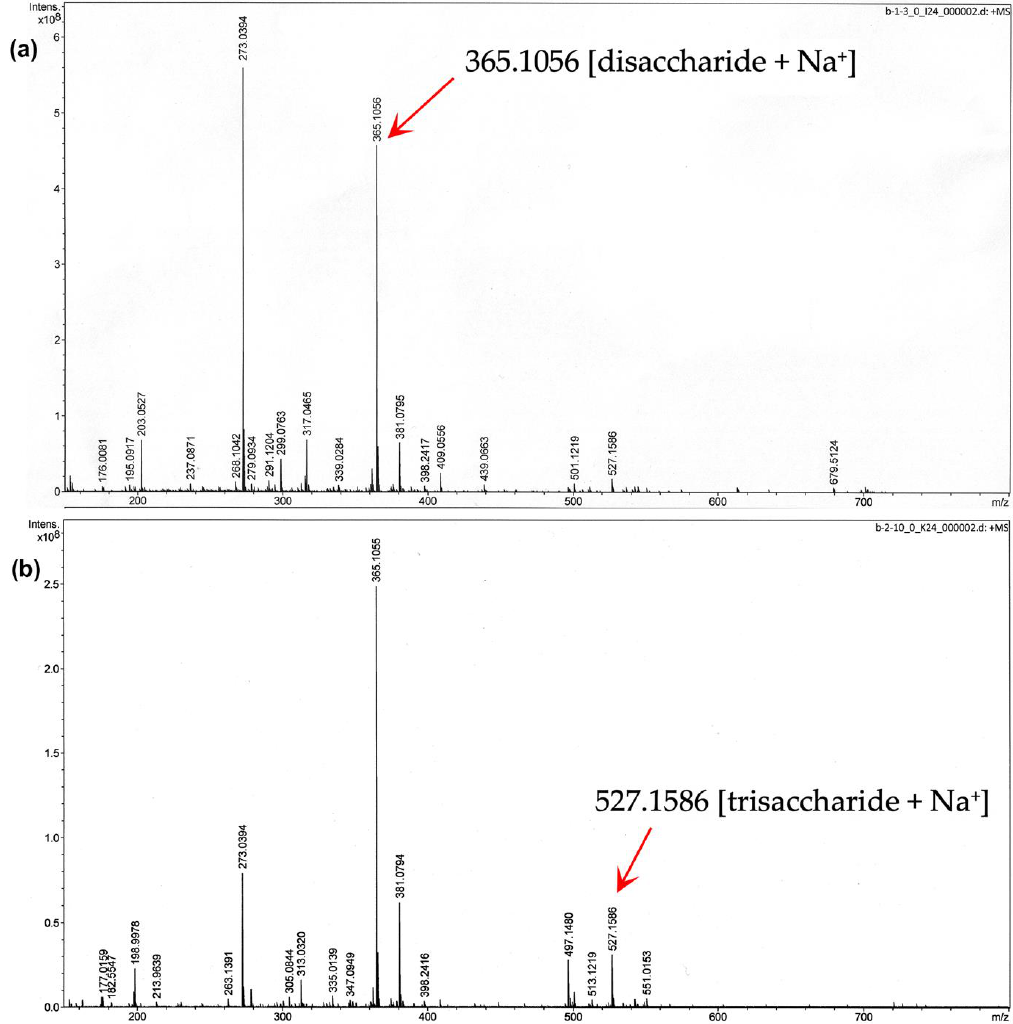
Figure 4. Mass spectrometry analysis of digested MOS5 ( a ) m-2 with sodium salt at 365 m / z, and ( b ) m-3 with sodium salt at 527.1586 m / z .